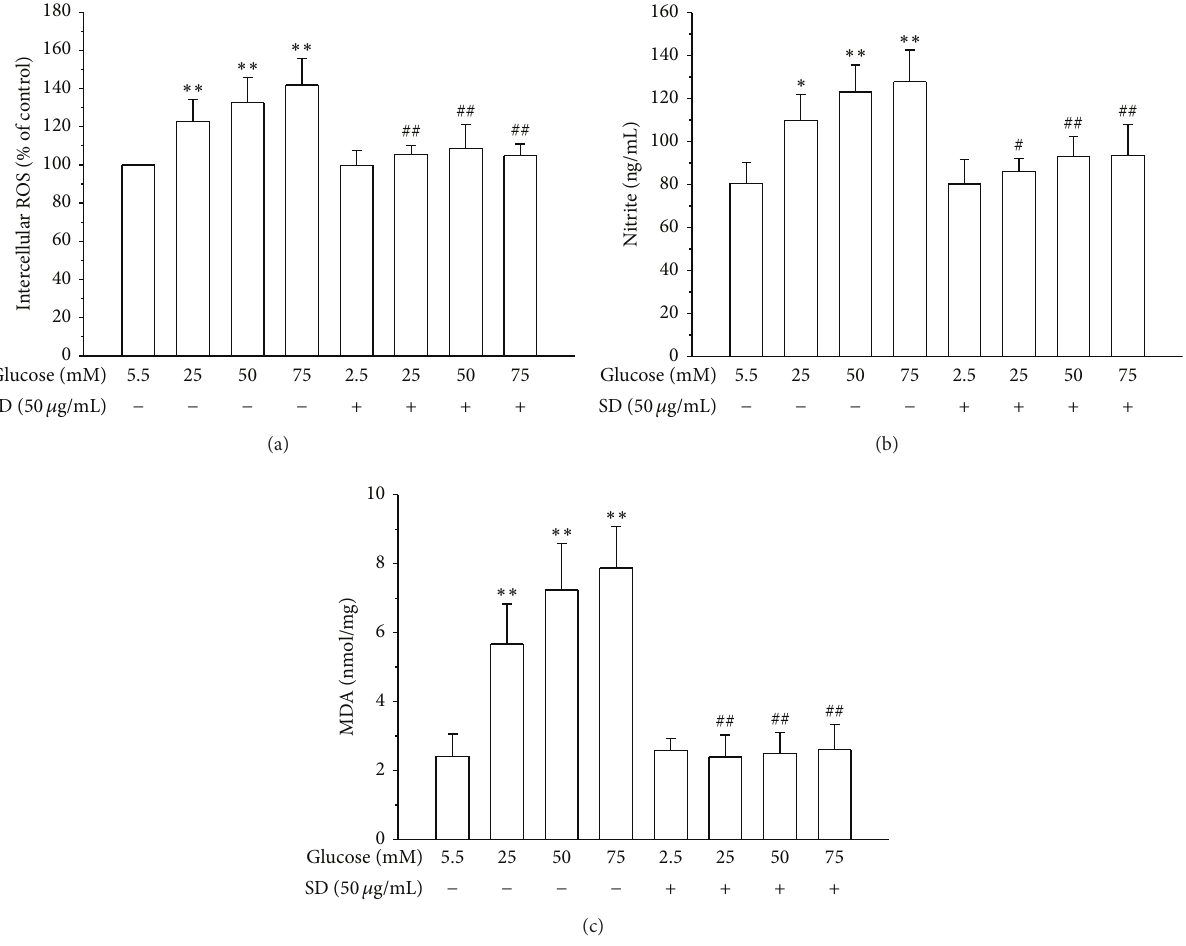
Figure 2: Effects of SD on HG-induced formation of ROS, NO, and LPO in HUVECs: (a) ROS production was determined as described in Materials and Methods; (b) the nitrite concentration in the culture medium was determined by Griess reagent; and (c) lipid peroxidation was assayed by measuring the amount of TBARS formation (malondialdehyde, MDA); Data are shown as the mean ± SEM of three independent experiments. ∗ 𝑃 < 0.05 ; ∗∗ 𝑃 < 0.01 , compared with the normal group; # 𝑃 < 0.05 ; ## 𝑃 < 0.01 , compared with the HG-treated